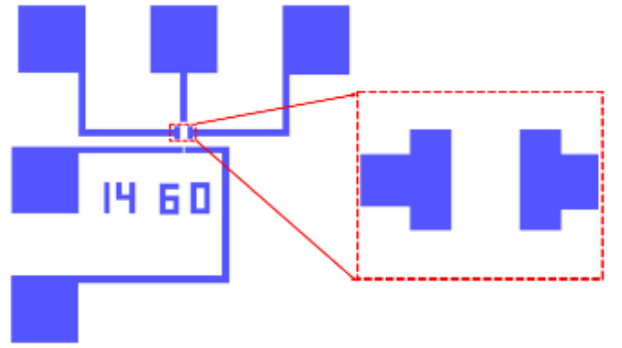
Figure 4. The layout of etching graphene under metal.